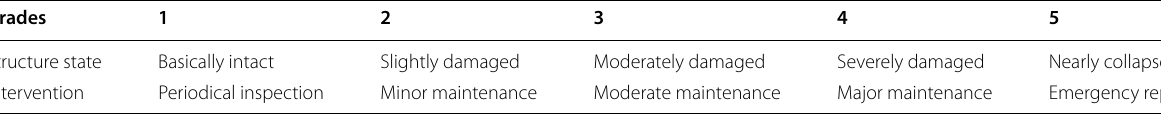
Table 3 Safety grading of ancient Chinese timber arch lounge bridges